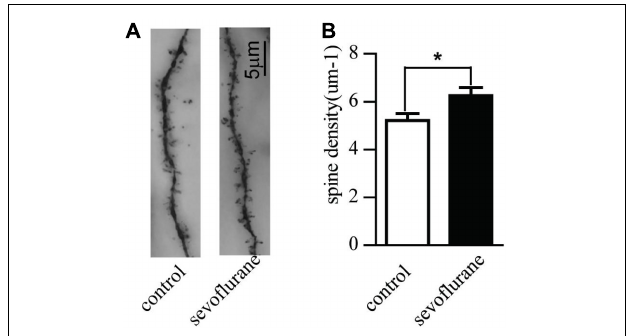
FIGURE 3 | Sevoflurane promoted the development of the pyramidal neurons in the hippocampal CA1 region with Golgi staining. Seven-day-old pups were exposed to 3% sevoflurane for 4 h and then allowed to grow up to 2 months. They were then subjected to the open field and water maze test. After which, their brain was removed for Golgi staining. (A) An example of Golgi staining dendritic spine morphology of the tertiary neurons from a Sham-treated or sevoflurane exposed mice; (B) the quantitative data of Golgi staining of the dendritic spine density of tertiary neurons. Data are presented as mean ± SEM ( n = 20 neurons from 3 mice); * P <